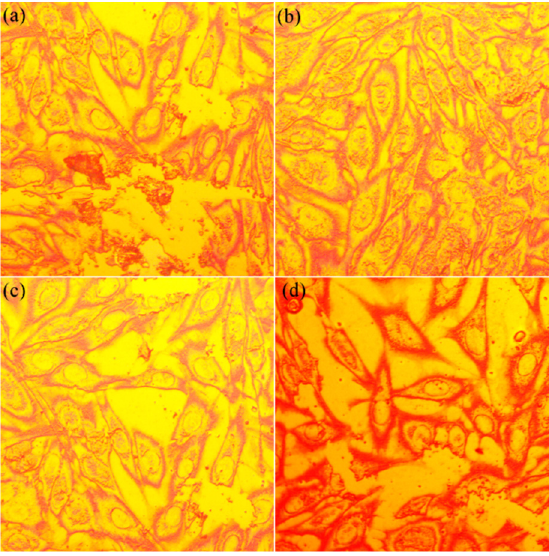
Figure 8. Metallographic microscopy images of MG63 cells after 48 h of incubation with Si discs ( a ), HApCh ( b ), 8MgHApCh ( c ) and 30MgHApCh ( d ) composite layers.